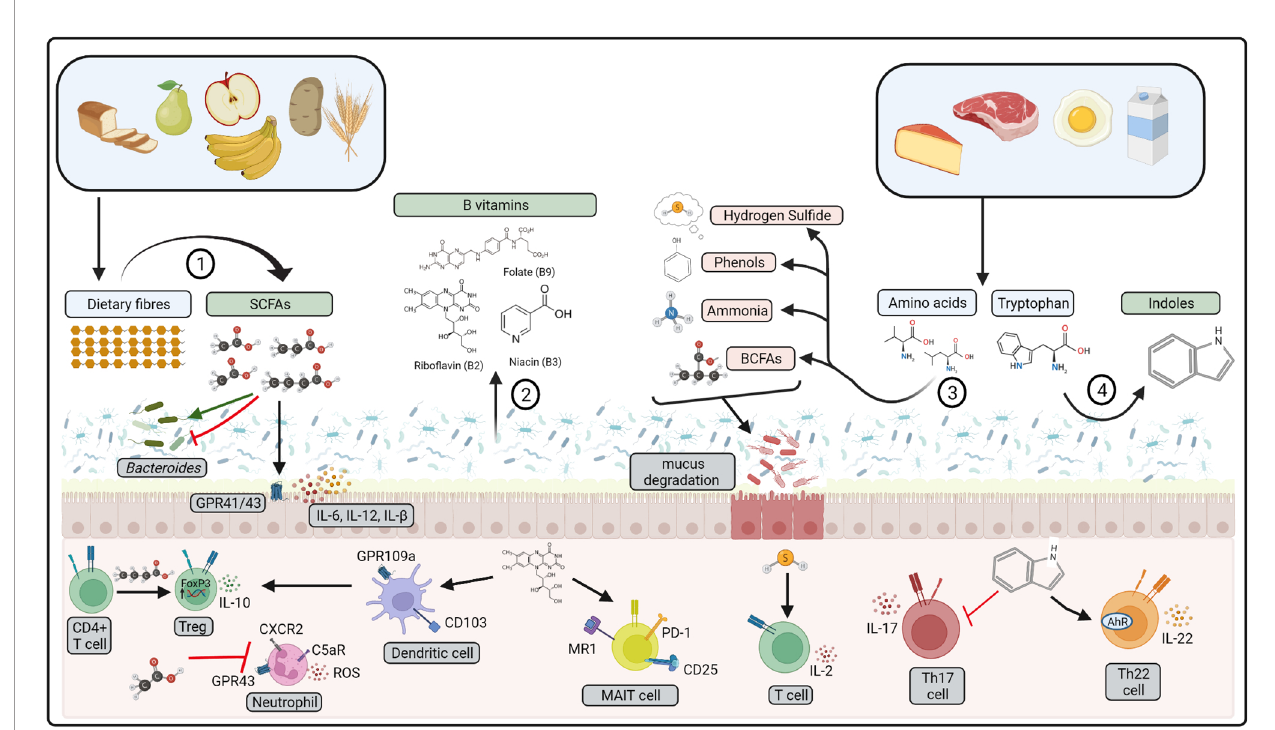
FIGURE 2 | Bioactive compounds produced by gut microbiota. 1) Dietary fi bres are fermented by gut microbiota to produce short-chain fatty acids (SCFAs), 2) B vitamins may be produced from gut microbiota metabolism. 3) Amino acids from dietary proteins may be fermented to produce branched-chain fatty acids (BCFA), ammonia, phenols, and hydrogen sul fi de. 4) Dietary tryptophan is metabolised by gut microbiota to indoles. Pro-in fl ammatory compounds represented in red, anti- in fl ammatory represented in green. These compounds affect host physiology via interactions with gut microbiota, colonic epithelial cells and mucosal immune cells. ROS: reactive oxygen species, MAIT, mucosal-associated invariant T cell. Created with